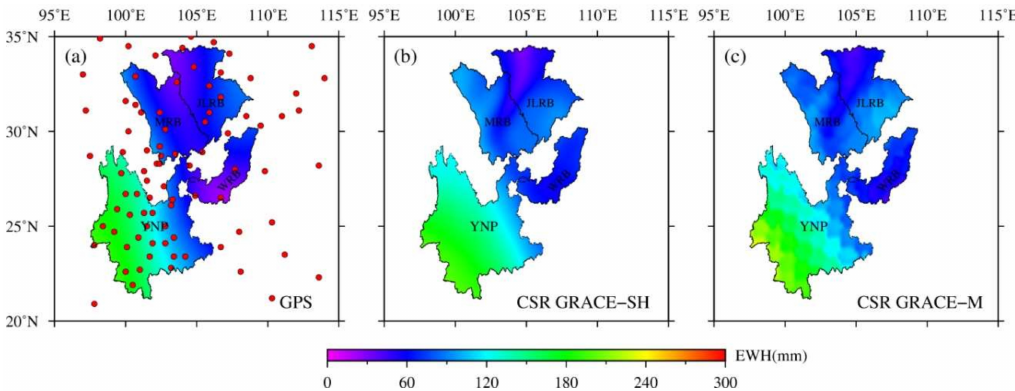
Figure 7. Comparisons of annual amplitudes of surface mass variations estimated by GPS vertical displacements, GRACE SH solutions, and mascon solutions during the period from January 2011 to June 2017. ( a ) Annual amplitudes inverted by GPS, the red dots indicate the location of GPS stations; ( b , c ) annual amplitudes inferred from CSR RL06 GRACE SH solutions (CSR GRACE-SH) and CSR RL06 GRACE mascon solutions (CSR GRACE-M), respectively.